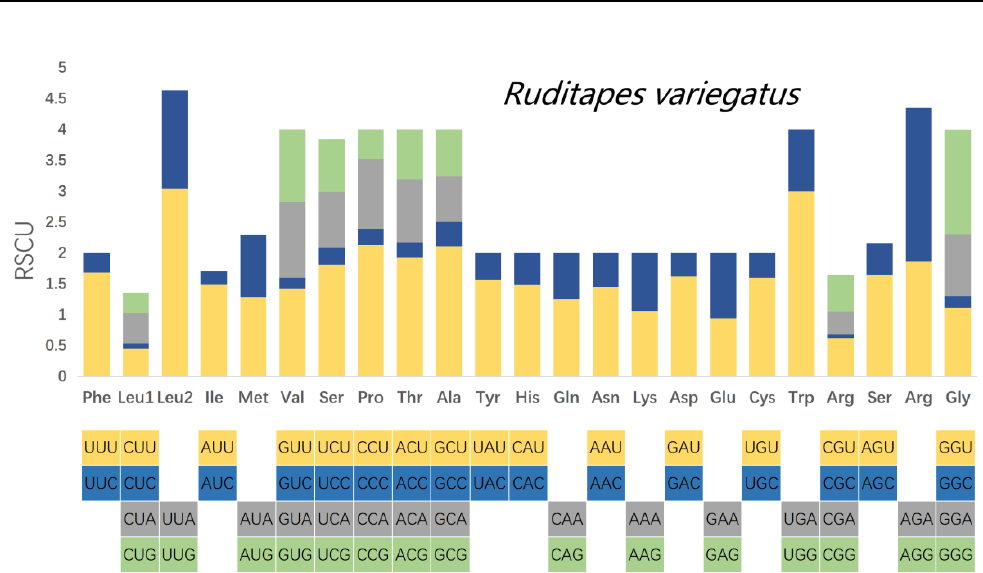
Figure 8. Relative synonymous codon usage (RSCU) in the mitochondrial genome of Ruditapes variegatus.